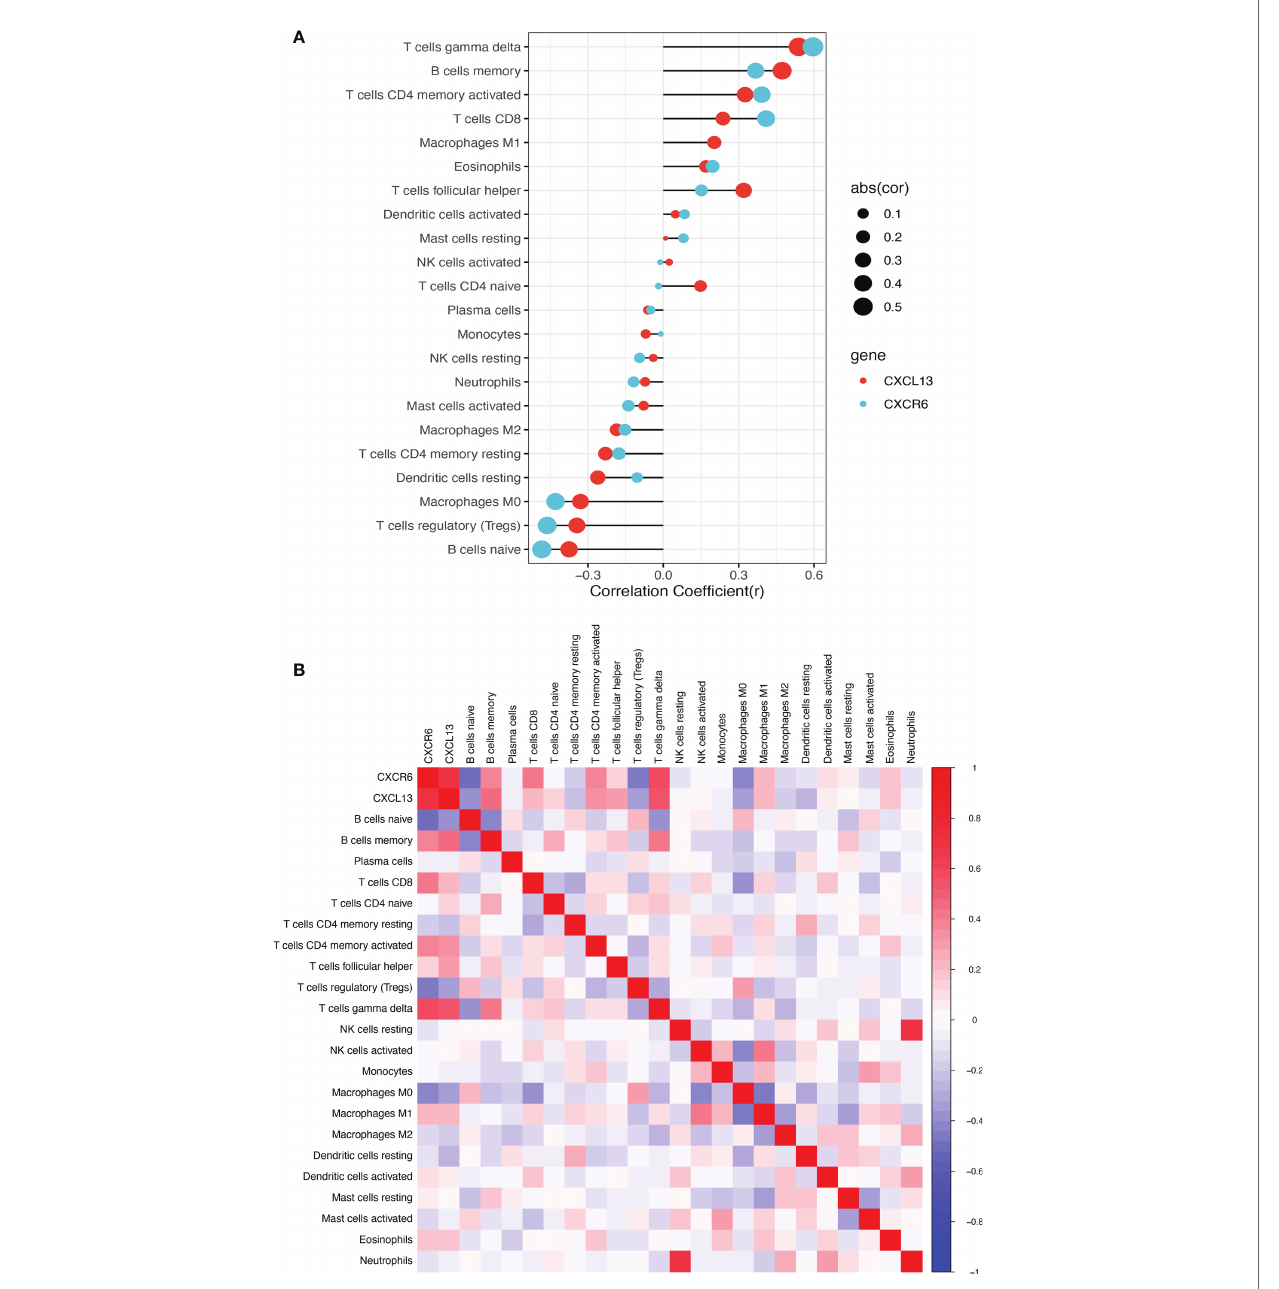
FIGURE 6 | The co-expression patterns among fractions of immune cells. (A) Correlation between the two biomarkers and in fi ltrating immune cells in TCMR. (B) Correlation matrix of all 22 immune cell subtype compositions and the two biomarkers. Both horizontal and vertical axes demonstrate immune cell subtypes. Immune cell subtype compositions (higher, lower, and same correlation levels are displayed in red, blue, and white,